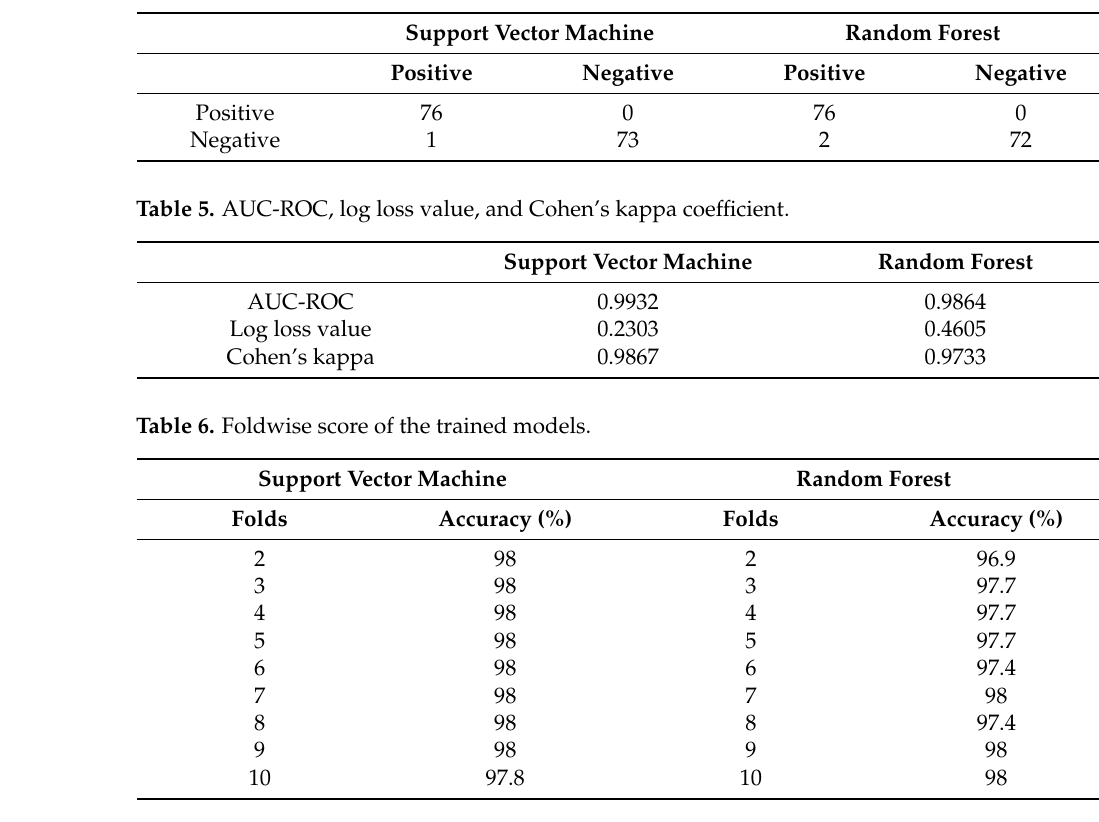
Figure 7. Precision and recall curves for ( a ) support vector machine and ( b ) random forest. Table 4. Confusion matrix for the trained models.